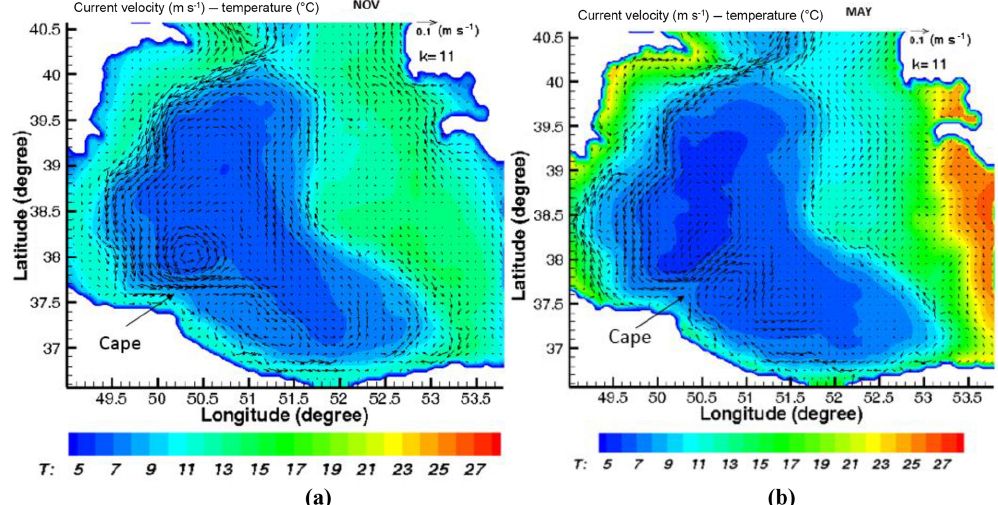
Figure 14. Monthly mean currents (ms − 1 ) in the layer “ k = 11”, obtained from the model simulations for May (a) and November (b) . The dense flow separates from the Sefid Rud Cape. The bottom deep, topographically trapped current over the Absheron sill and the southern Caspian Sea basin is marked. k = 1 is the bottom layer and k = 30 is the top